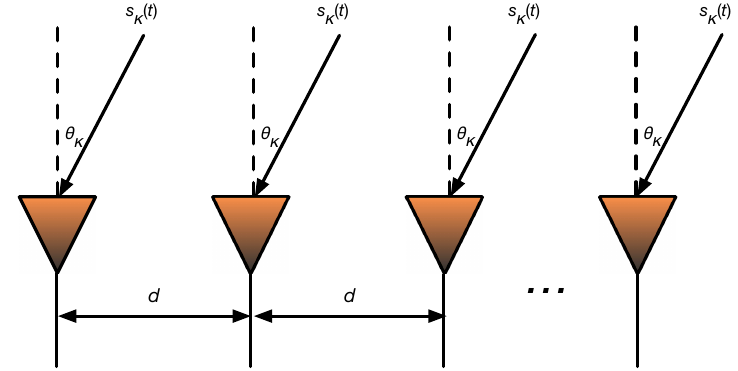
Figure 1. The ULA system for direction